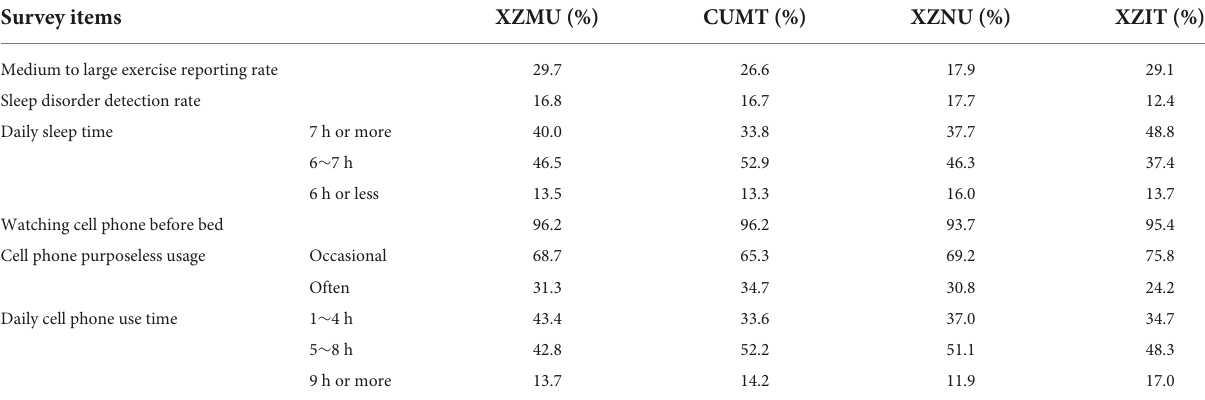
TABLE 3 Comparison of survey items among four